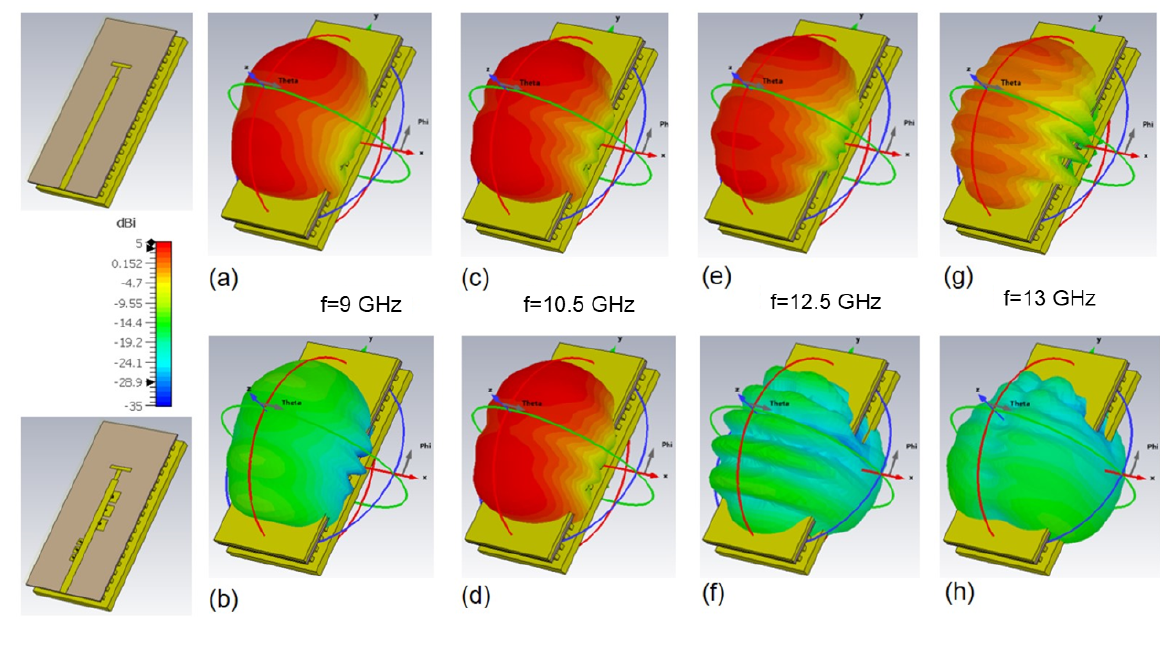
Figure 13. Simulated 3D radiation patterns for the reference and filtering antenna at different fre- quencies: ( a ) reference at f = 9 GHz ( b ) filtering at f = 9 GHz ( c ) reference at f = 10.5 GHz ( d ) filtering at f = 10.5 GHz ( e ) reference at f = 12.5 GHz ( f ) filtering at f = 12.5 GHz ( g ) reference at f = 13 GHz and ( h ) filtering at f = 13